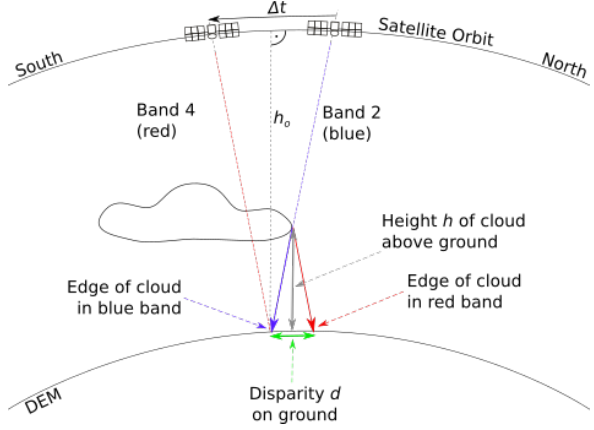
Figure 2. Principle of acquisition geometry of image bands separated in a FPA; h o : height of the orbit, ∆ t : time lag as listed in table